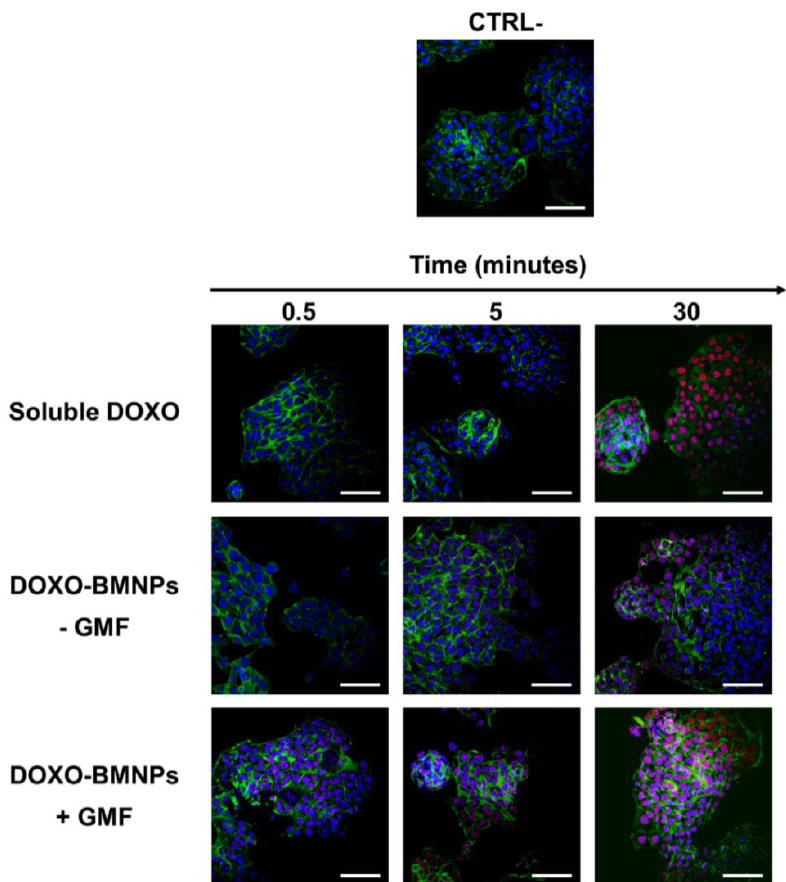
Figure 4. The apposition of a GMF enhances the cellular uptake of Doxorubicin (DOXO) coupled to BMNPs. 4T1 cells were incubated at 37 °C with DOXO-BMNPs for different times (0.5, 5, and 30 min) in the absence (−GMF) and presence (+GMF) of a gradient magnetic field. Soluble DOXO was used as a positive control. Cells were fixed, permeabilized, stained for cytoskeletal actin with fluorescein isothiocyanate (FITC)-phalloidin (green) and for nuclei with TO-PRO3 (blue) and visualized at confocal microscopy. DOXO was detectable for its intrinsic fluorescence in red. Scale bar: 50µm.